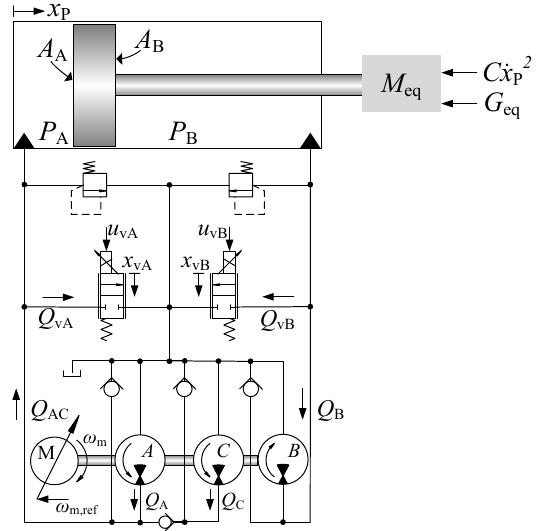
Figure 1: Asymmetric cylinder controlled by SvSDP- system.